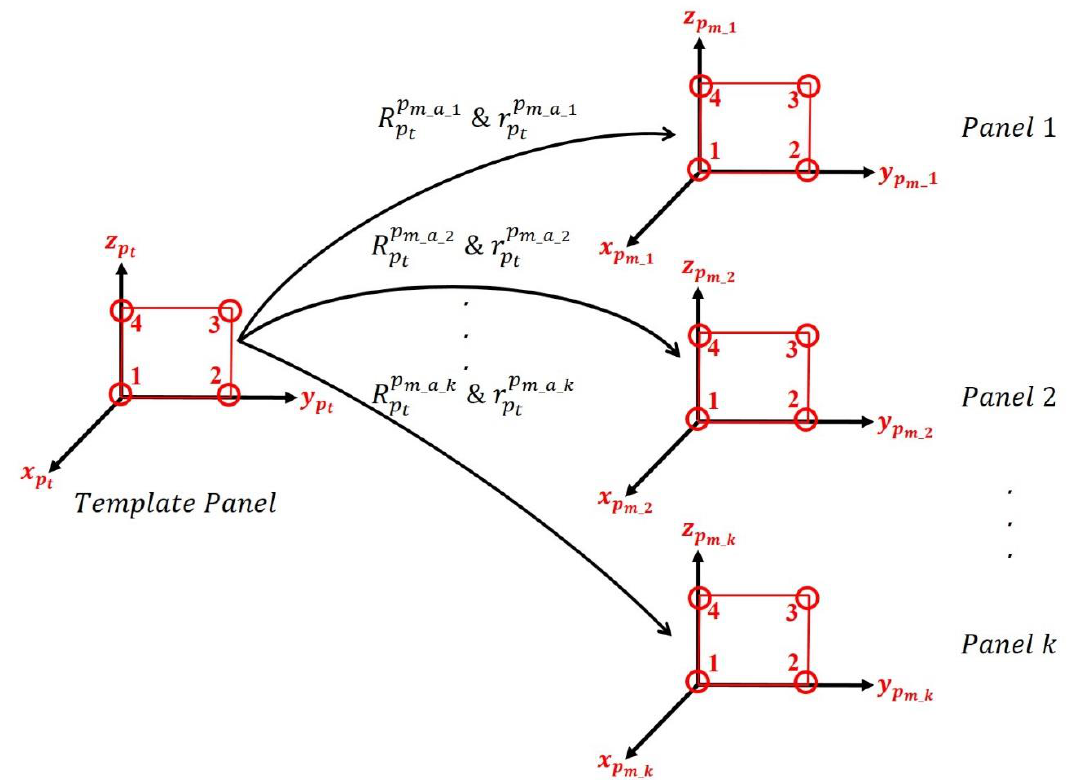
Figure 16. Refined panel coordinate system ( P cs ) through the estimated transformation parameters relating the template and matching panels.